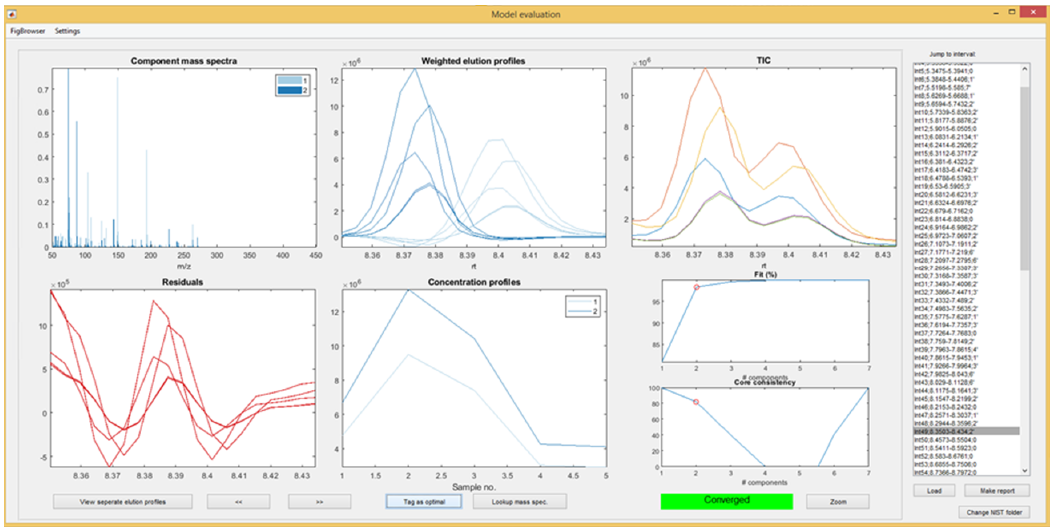
Figure 2. PARADISe model evaluation window with PCB 28 and parathion-methyl peaks (sample S3). Original chromatogram and four additional chromatograms derived from it. The original file was modified with the following parameters, which were generated randomly (retention time shifter [min], multiplier): (−0.00156, 1.99866); (0.00221, 1.56173); (0.00158, 0.63779); (−0.00107, 1.00608).